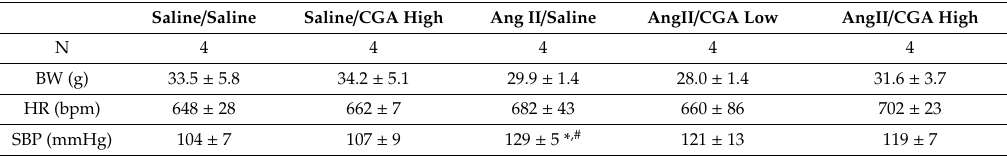
Table 1. Characteristics of the study mice.